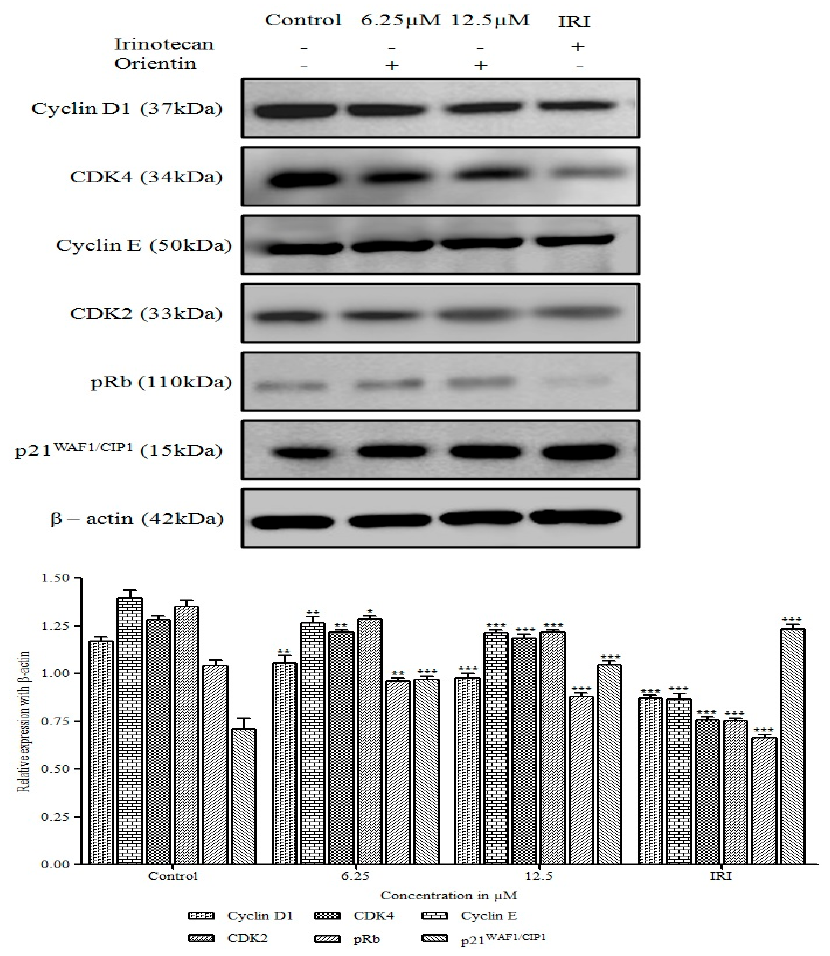
Figure 5. E ff ect of orientin on cell cycle regulatory proteins. HT29 cells were treated with orientin (6.25 and 12.5 µ M) and irinotecan for 24 h. The immunoblot analysis of cyclins, CDKs and their inhibitors involved in G0 / G1 phase were carried out. Orientin reduced the expression of cyclins, pRb and CDKs, in contrast, increased the level of p21 WAF1 / CIP1 . β -actin was used as an internal control. Quantitative expression of proteins shown after normalization to β -actin. The data presented are the mean ± SD of results from three independent experiments (* p < 0.05, ** p < 0.01 and *** p < 0.001 vs. control).